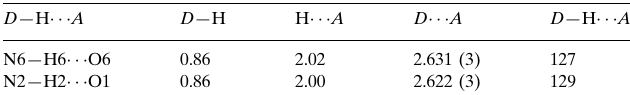
Hydrogen-bond geometry (A˚ , (cid:1)